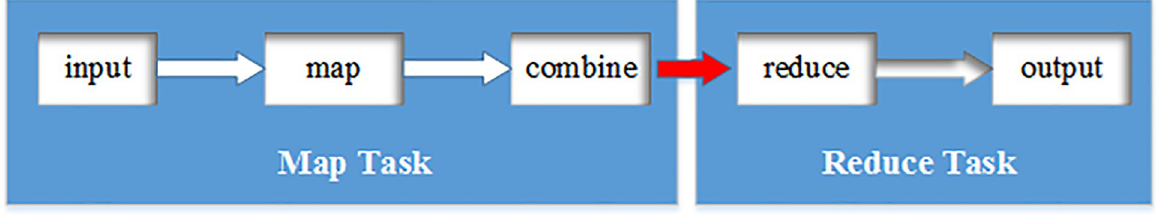
Fig 4. MapReduce data flow